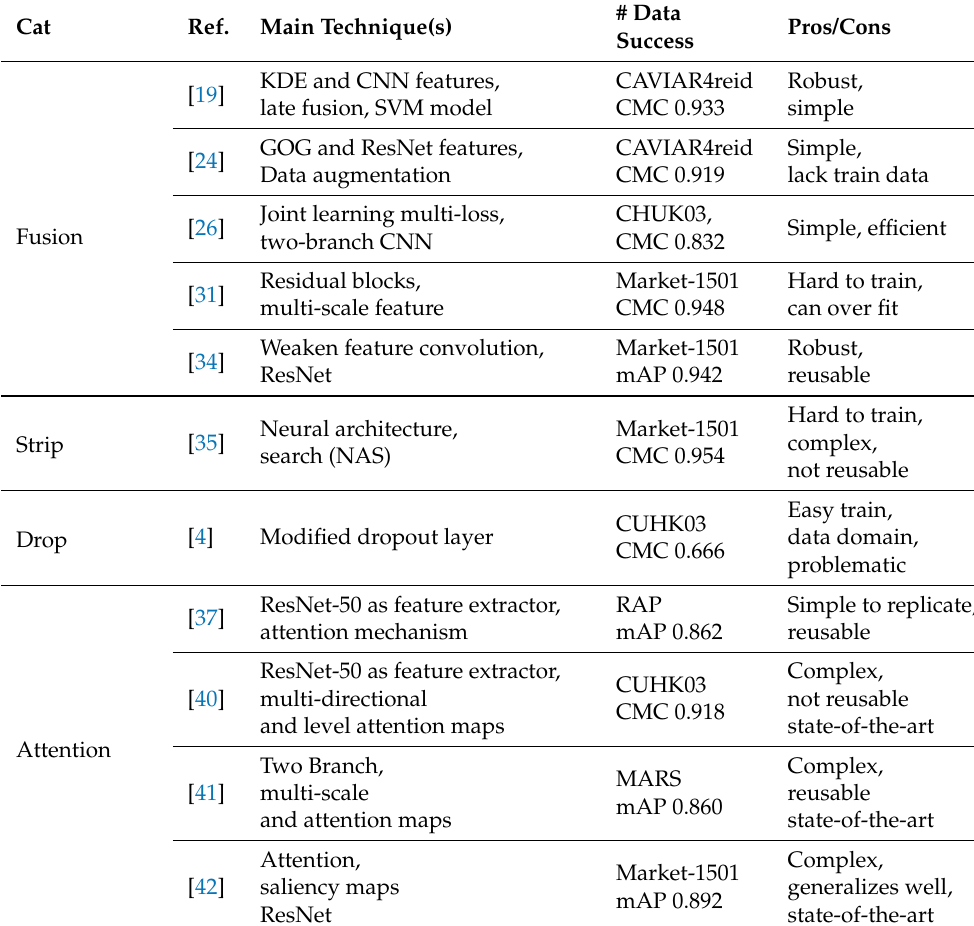
Table 2. Performance evaluation of the reviewed person ReID using feature learning methods.